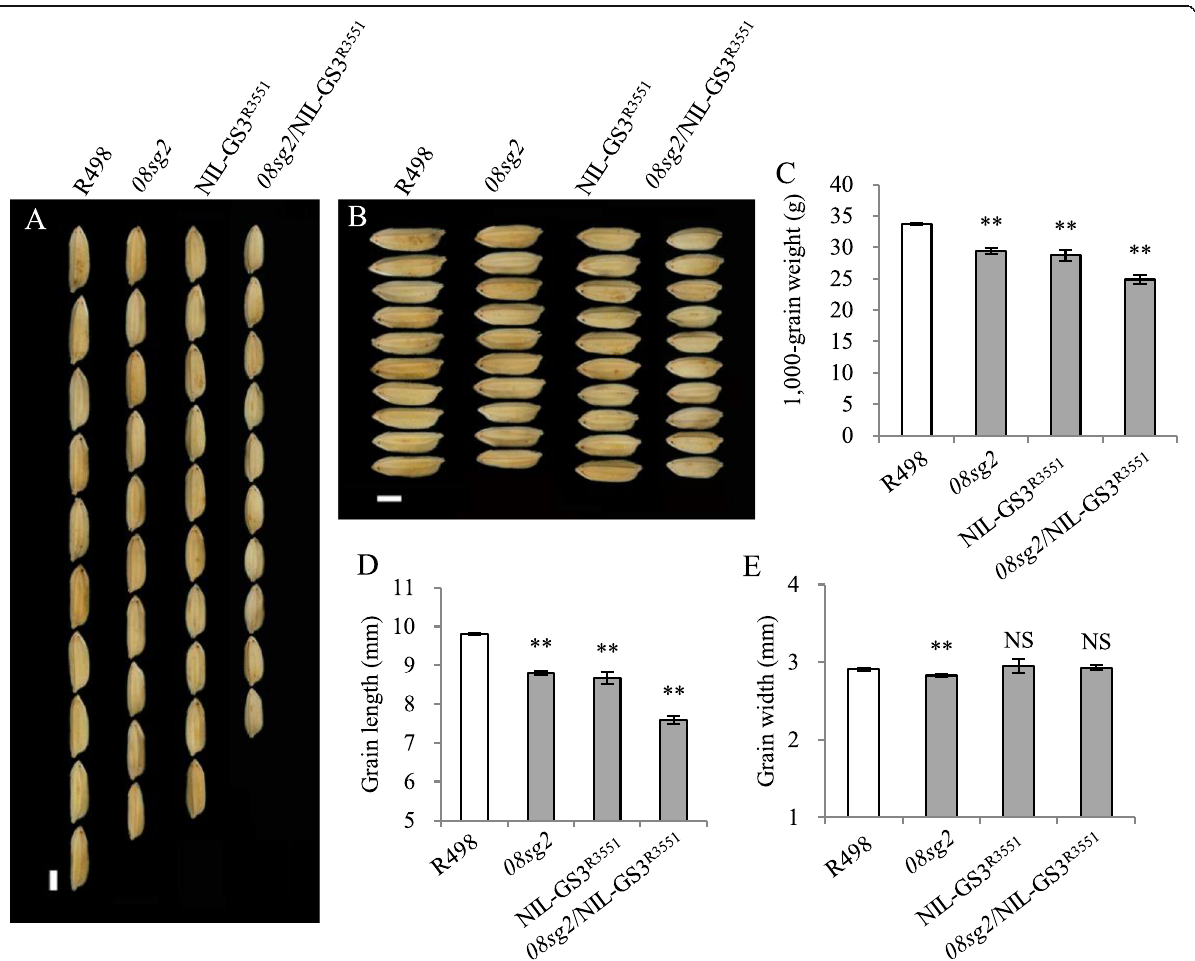
Fig. 5 08SG2 / OsBAK1 and GS3 regulate grain length in independent pathways. a , b Grain length and grain width performance in different plants, respectively. c - e The data statistical analysis of 1,000-grain weight, grain length, grain width in different plants, respectively. Data are given as means± SD. Student ’ s t-test was used to generate the P values; ** and NS indicate P < 0.01 and no significant differences,